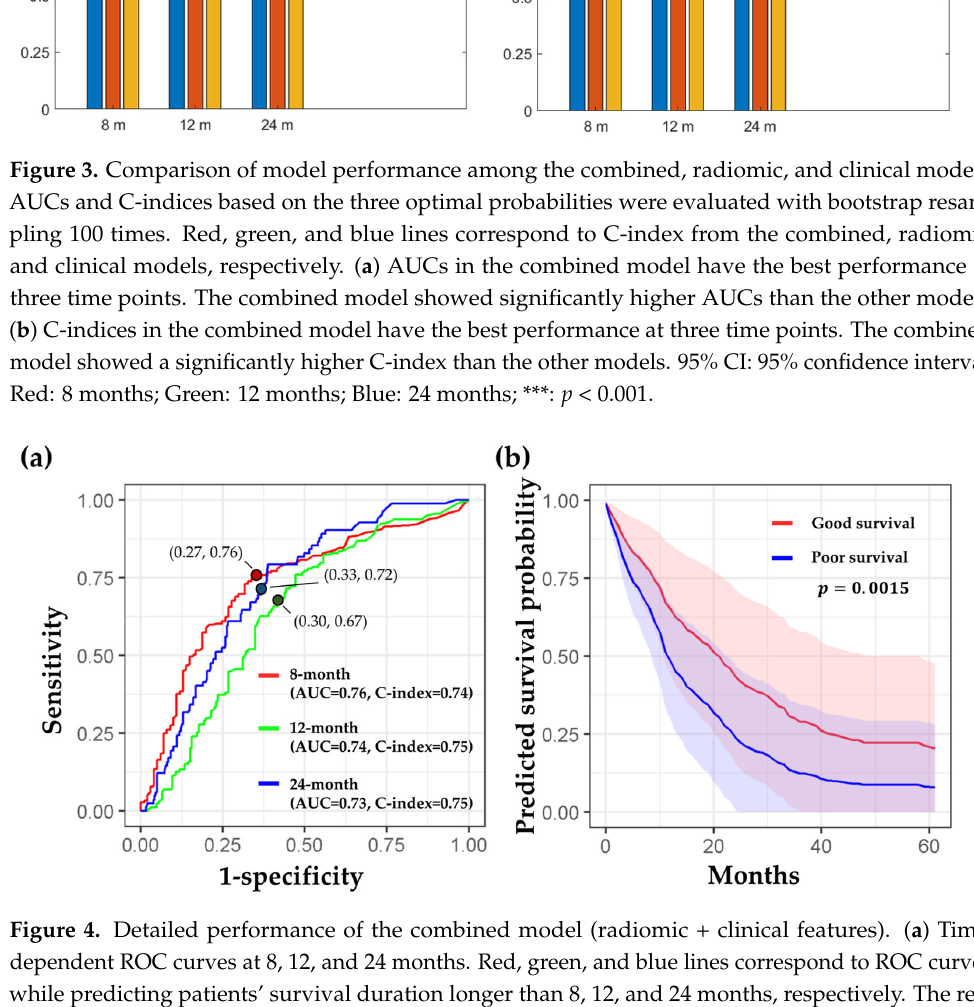
Figure 3. Comparison of model performance among the combined, radiomic, and clinical models. AUCs and C-indices based on the three optimal probabilities were evaluated with bootstrap resampling 100 times. Red, green, and blue lines correspond to C-index from the combined, radio- mic, and clinical models, respectively. ( a ) AUCs in the combined model have the best performance at three time points. The combined model showed significantly higher AUCs than the other models.